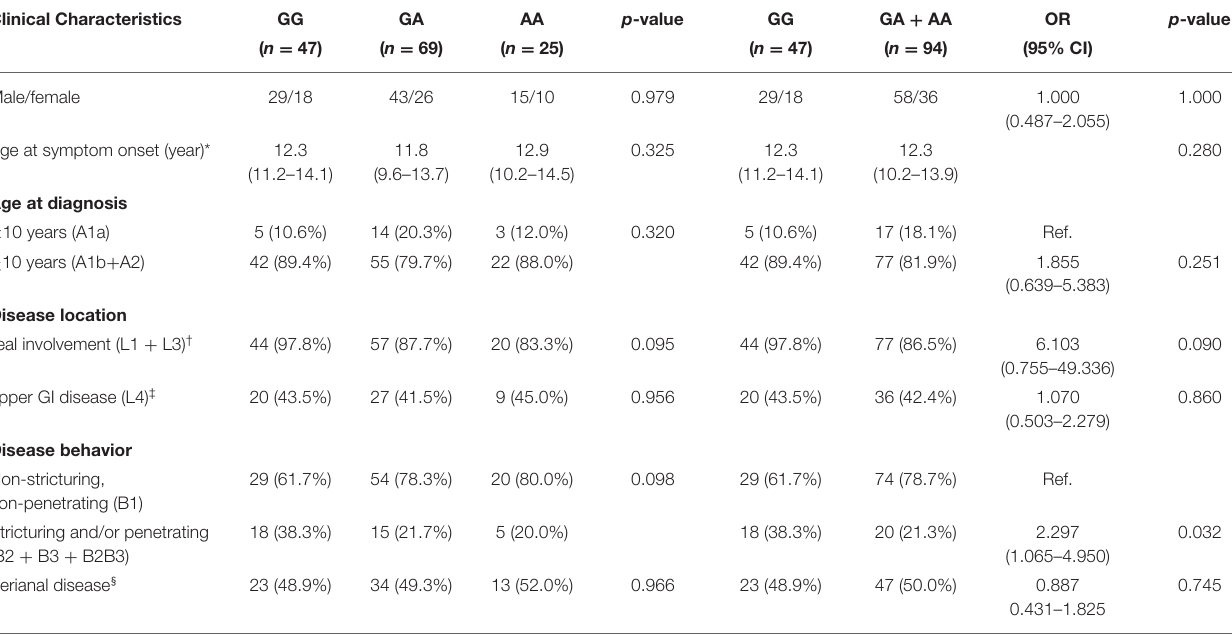
TABLE 5 | Association between rs1495965 genotypes and phenotypes in patients with Crohn’s